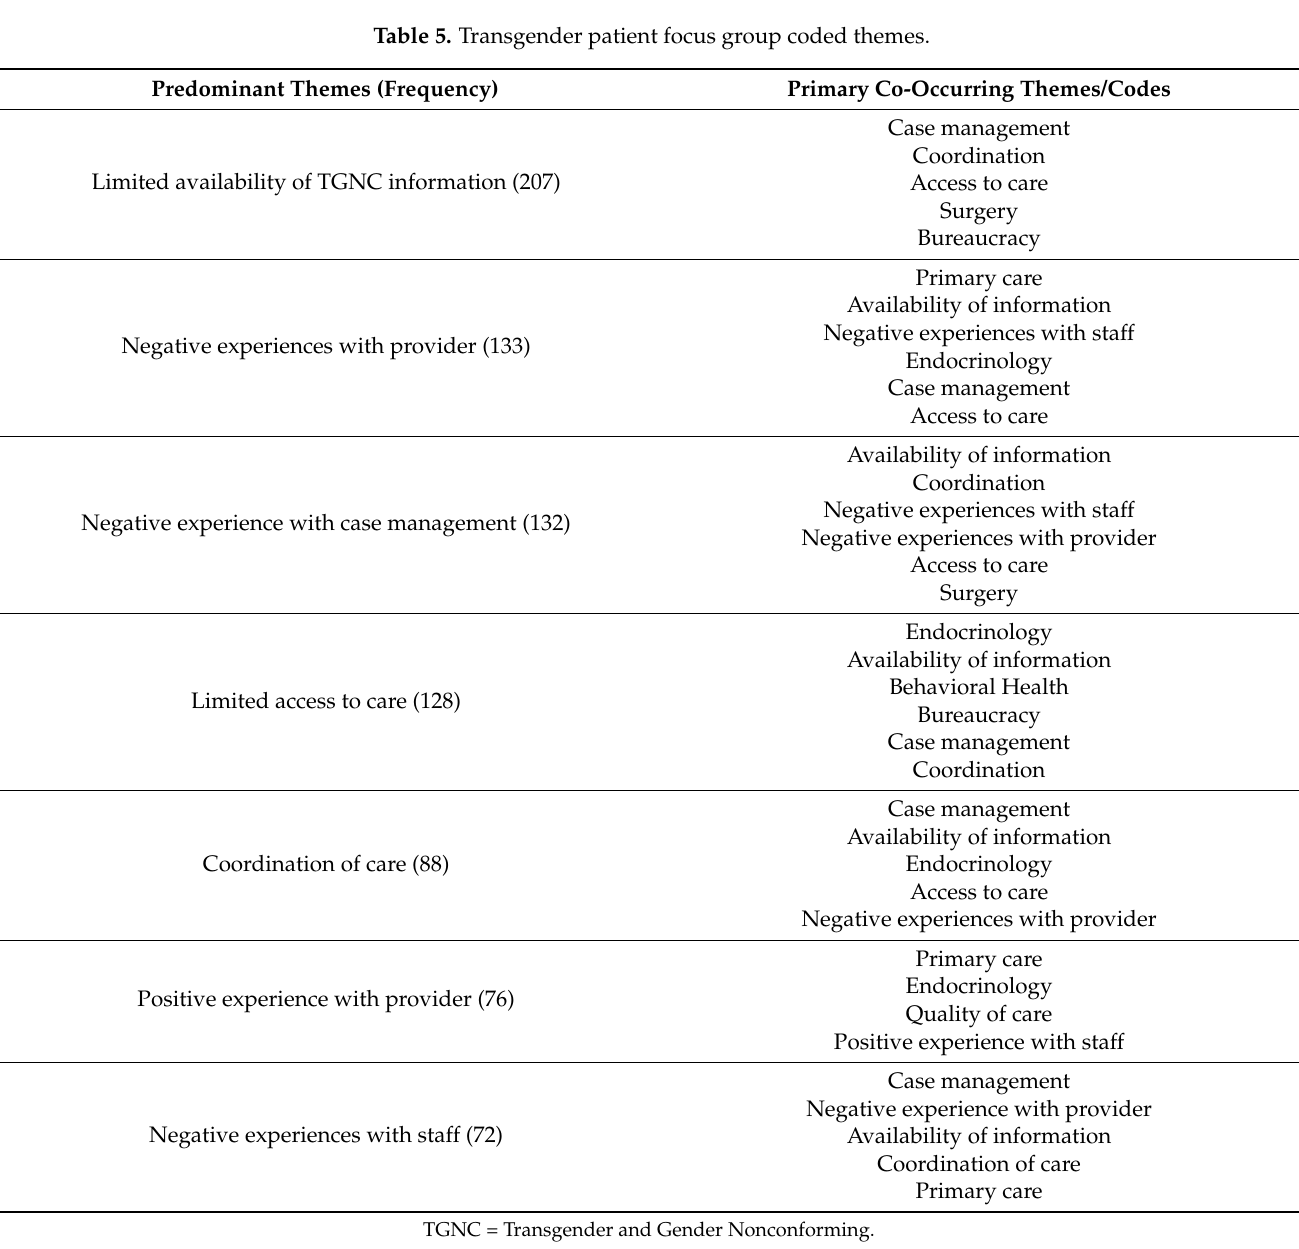
Table 5. Transgender patient focus group coded